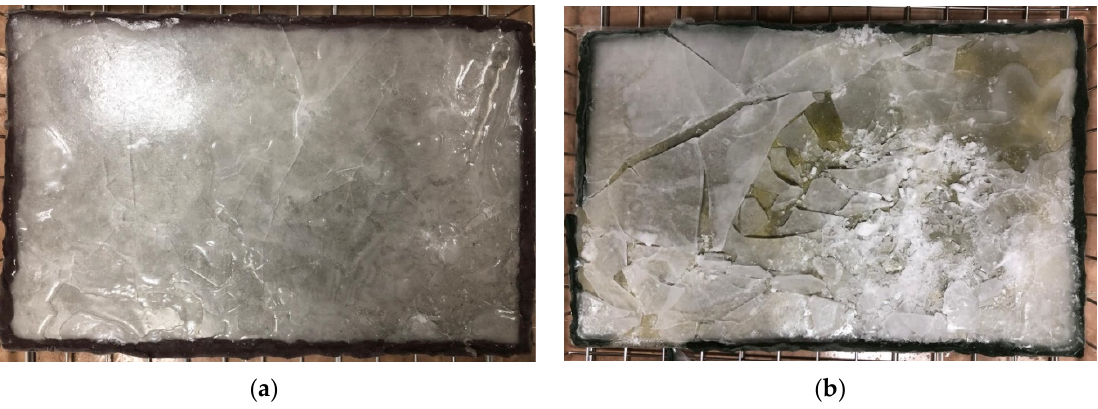
Figure 5. Specimens after vibration test. ( a ) Not coated, ( b ) Coated.